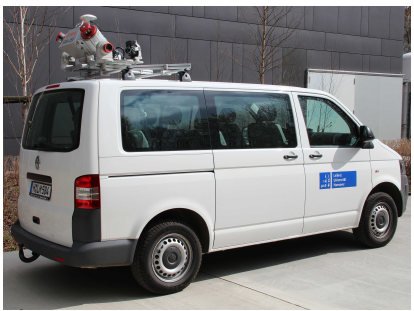
Figure 1. Riegl VMX-250 placed on a Mobile Mapping van.